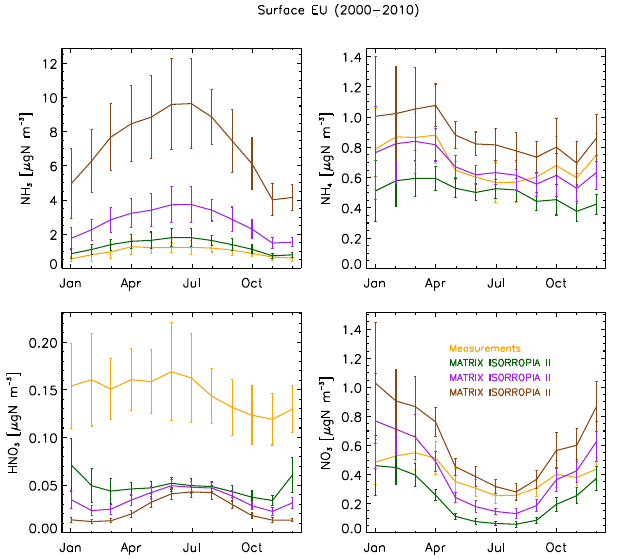
Figure 8. The 2000–2010 mean annual cycle over Europe, error bars represent ± 1 standard deviation. Measurements are in or- ange, MATRIX-ISORROPIA II with regular emissions is in green, with double agricultural NH 3 emissions in purple, and with 5 times higher agricultural NH 3 emissions in brown.